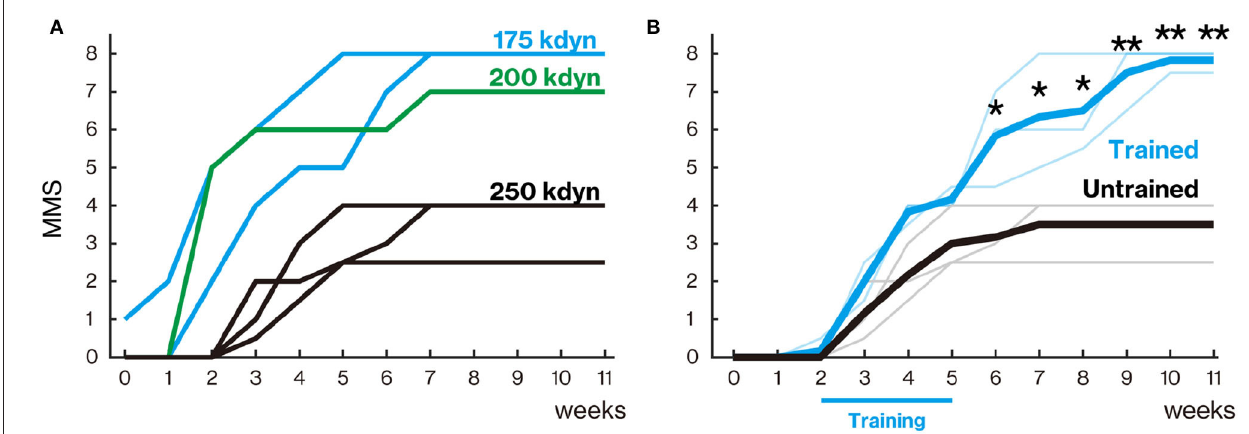
FIGURE 2 | Treadmill training promoted locomotor function recovery. (A) Marmoset Motor Scale for Locomotion (MMS) with mild (175 and 200 kdyn) and severe (250 kdyn) contusion groups. Animals with mild contusion gradually recovered their stepping ability, while animals with a severe injury could hardly move their hindlimb until 2 weeks after spinal cord injury (SCI). A detailed explanation of MMS is described in Table 3 . (B) MMS for the trained and untrained group with severe contusions. Thin and thick lines indicate MMS for each animal and their mean, respectively. Animals in the untrained group gradually recovered and reached a plateau around 5 weeks. In the trained group, the difference in locomotor performance was not seen during the training period (from 2 to 5 weeks after injury); they gradually recovered even after 6 weeks. * p < 0.05; ** p < 0.01; Welch’s t -test.